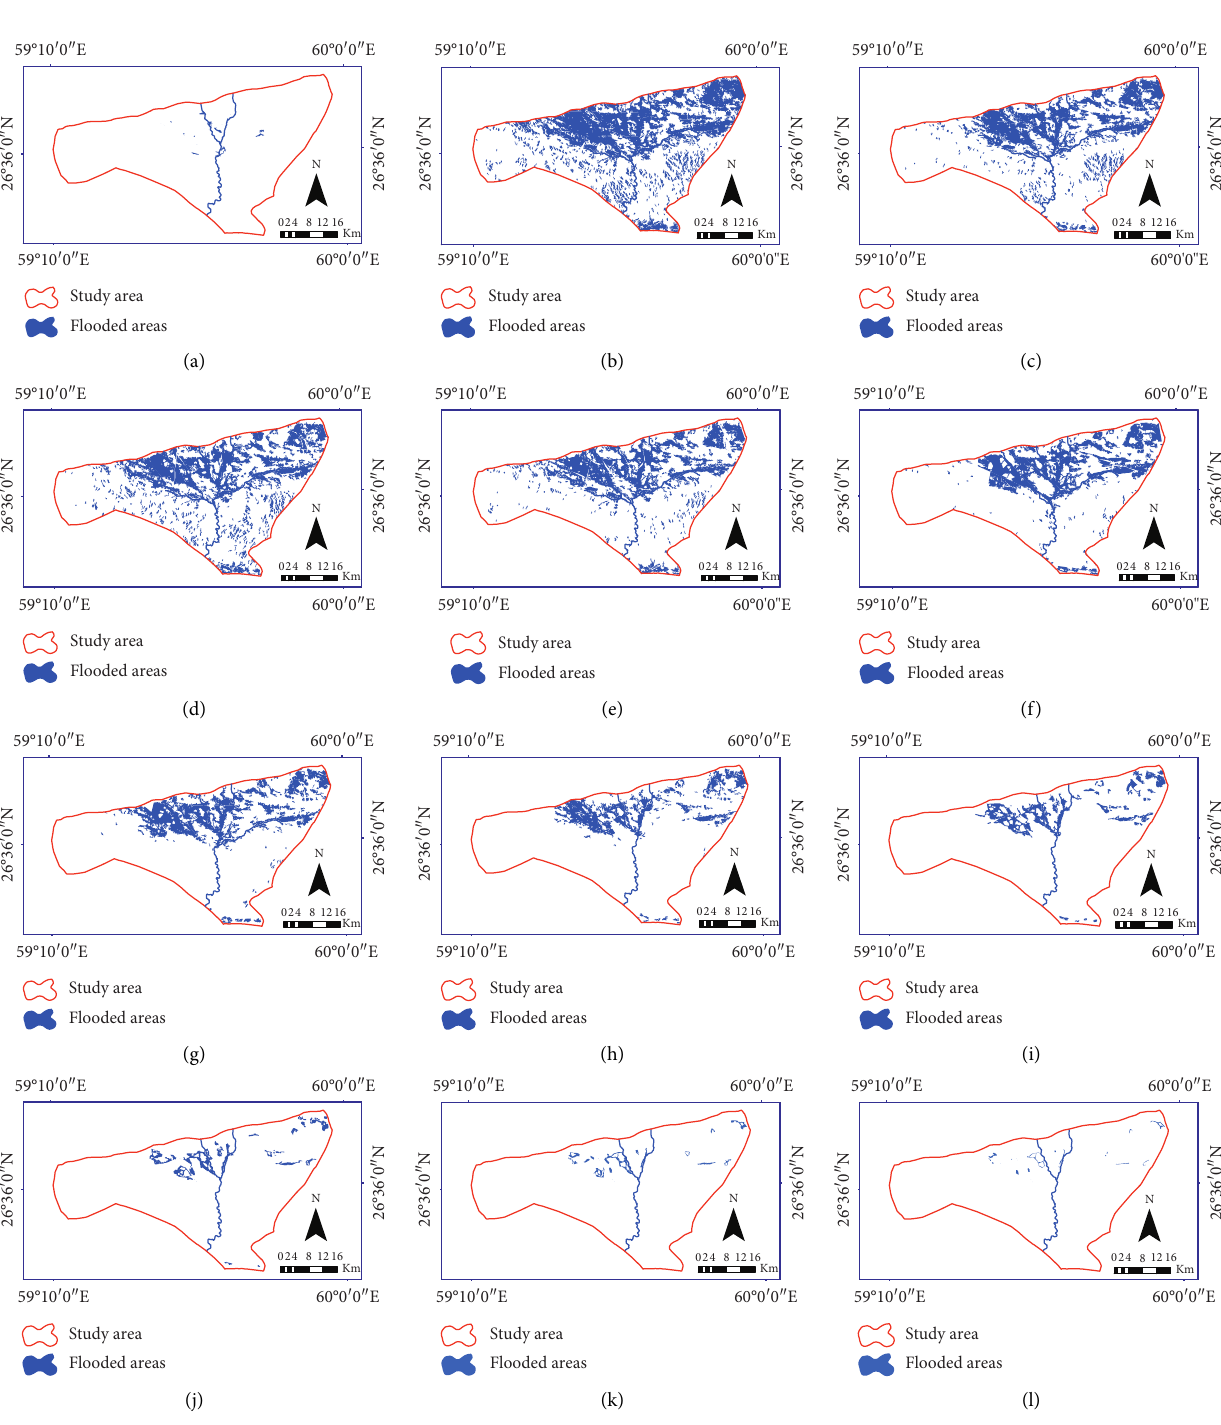
Figure 14: Flooded areas determined by Sentinel-1 data for different times. (a) 31 December 2019. (b) 12 January 2020. (c) 18 January